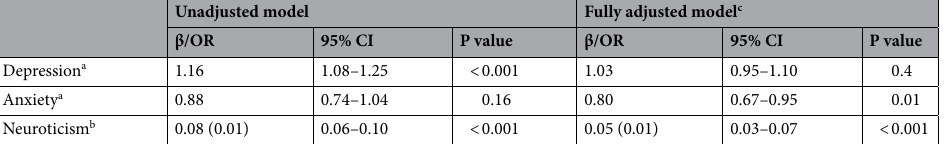
Table 2. Regression models for the association between RA and mental health. a Logistic regression with OR. b Linear regression with standardized betas and SE. c Adjusted for the covariates of age, sex, ethnicity (White British vs Other), deprivation index, smoking status, BMI and alcohol intake.